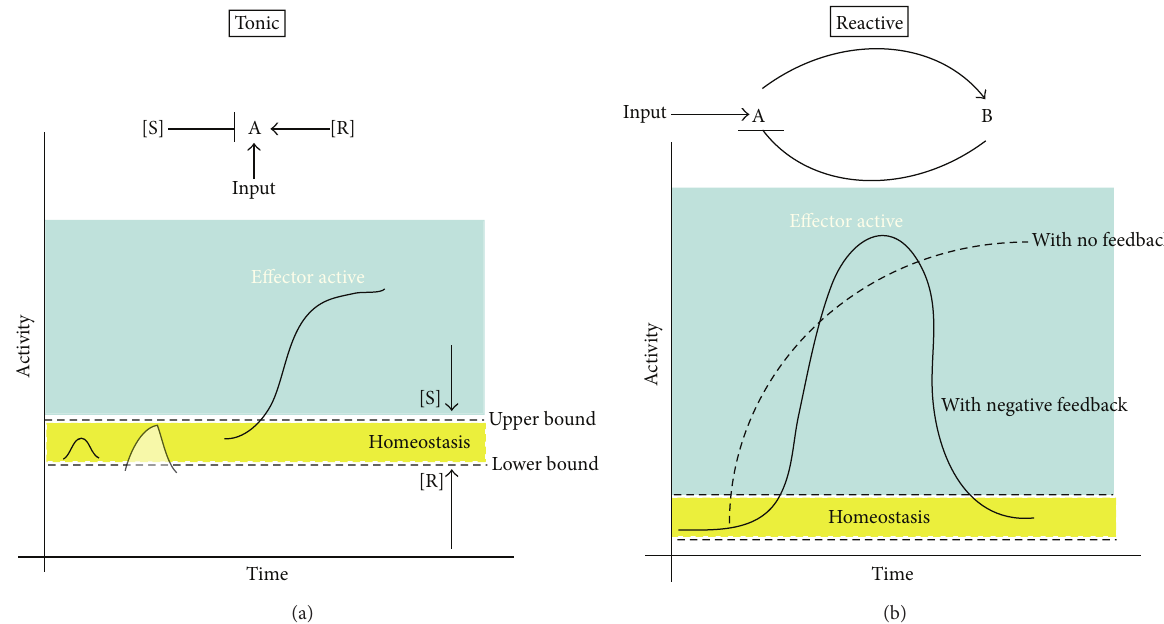
Figure 1: Tonic and reactive regulatory motifs: (a) the tonic regulatory motif maintains homeostasis by adjusting the concentration of a suppressor [S], which sets the upper bound of the activating threshold. In some cases, basal levels of an activator [R] establish the lower bound. (b) The reactive regulatory motif maintains homeostasis typically through a negative feedback loop. Negative feedback produces spiked activation and oscillations under some